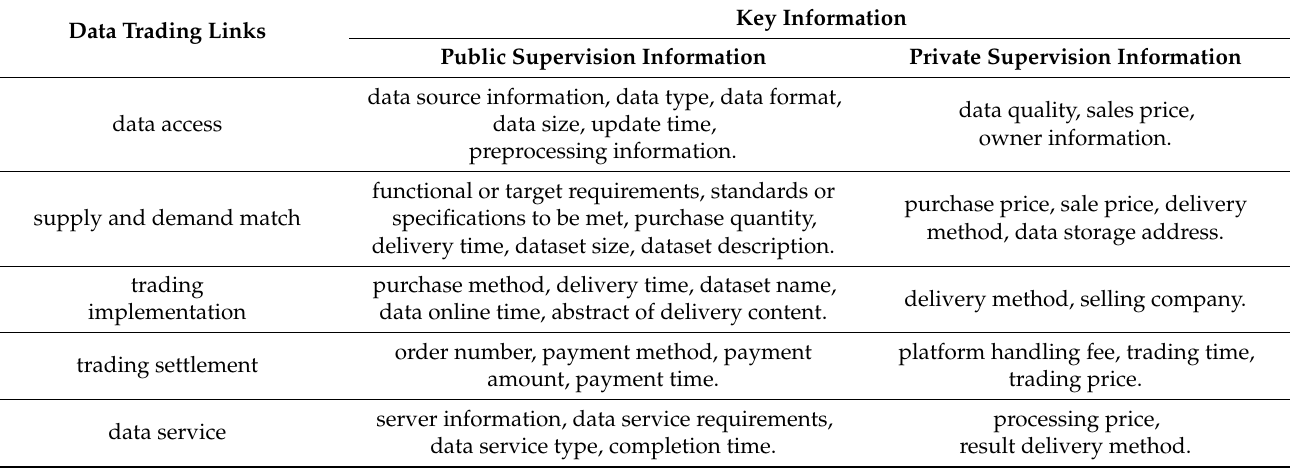
Table 1. Key information of each link in the data trading